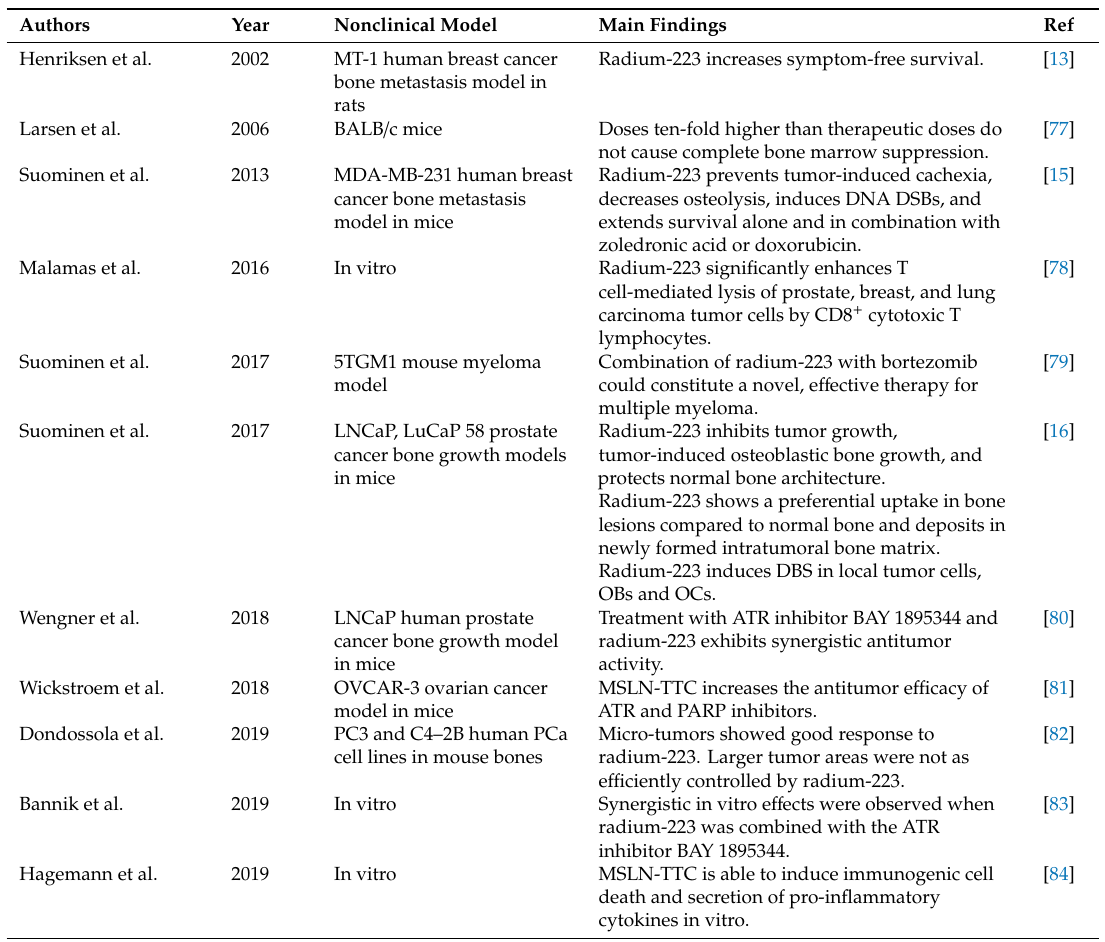
Table 1. The main findings of radium-223 in nonclinical cancer